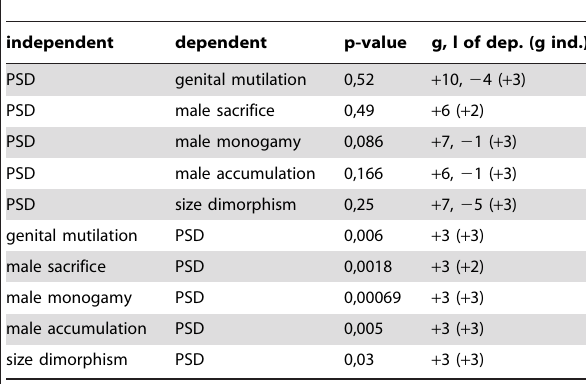
Table 2. Hypotheses of the evolution of PSD tested using the concentrated change test for one of the phylogenies used by Miller ([21], topology "Kuntner et al. ((TA)(EN))").